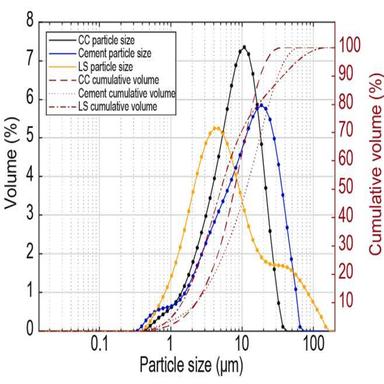
Particle size distribution of calcined clay, cement, and limestone.